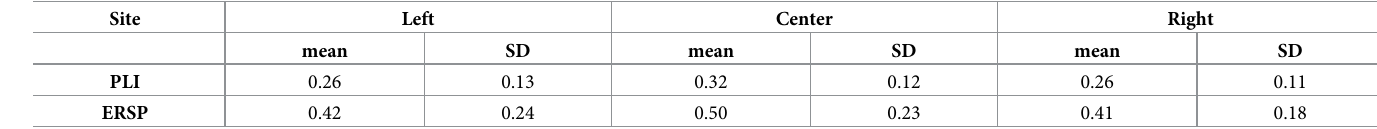
Table 1. Means and standard deviations of PLIs and ERSPs values during the 40-Hz stimulation for the left, central and right regions. Site Left Center Right mean SD mean SD mean SD PLI 0.26 0.13 0.32 0.12 0.26 0.11 ERSP 0.42 0.24 0.50